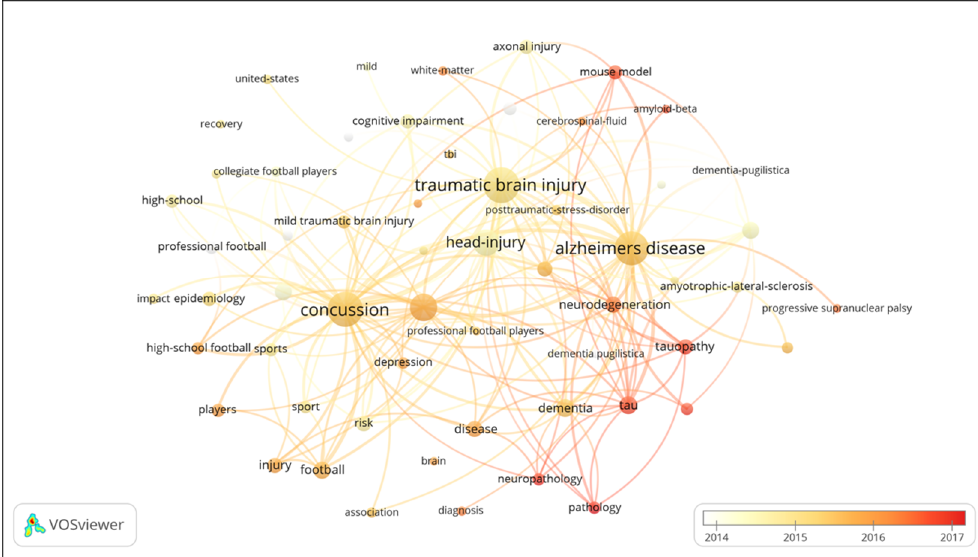
Figure 10. Distribution of keywords based on the time of appearance. Keywords marked by the circles in di ff erent colors (yellow early; red